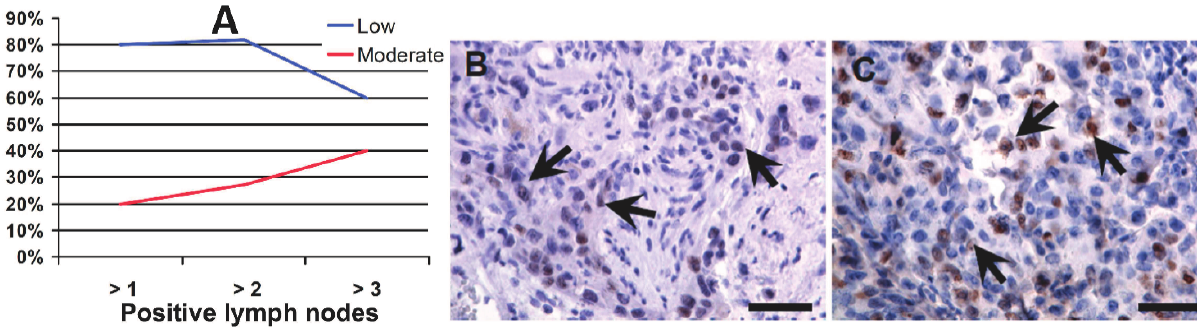
Figure 1. OCT4A expression in a primary tumor: percentage of cases ( A ) with low ( B ) and with moderate ( C ) expression in tumors with an increasing number of metastases to regional lymph nodes. Arrows show Oct4A-positive nuclei (visualized with diaminobenzidine (DAB) (brownish) and counterstained with hematoxylin (blue)); scale bars: 100